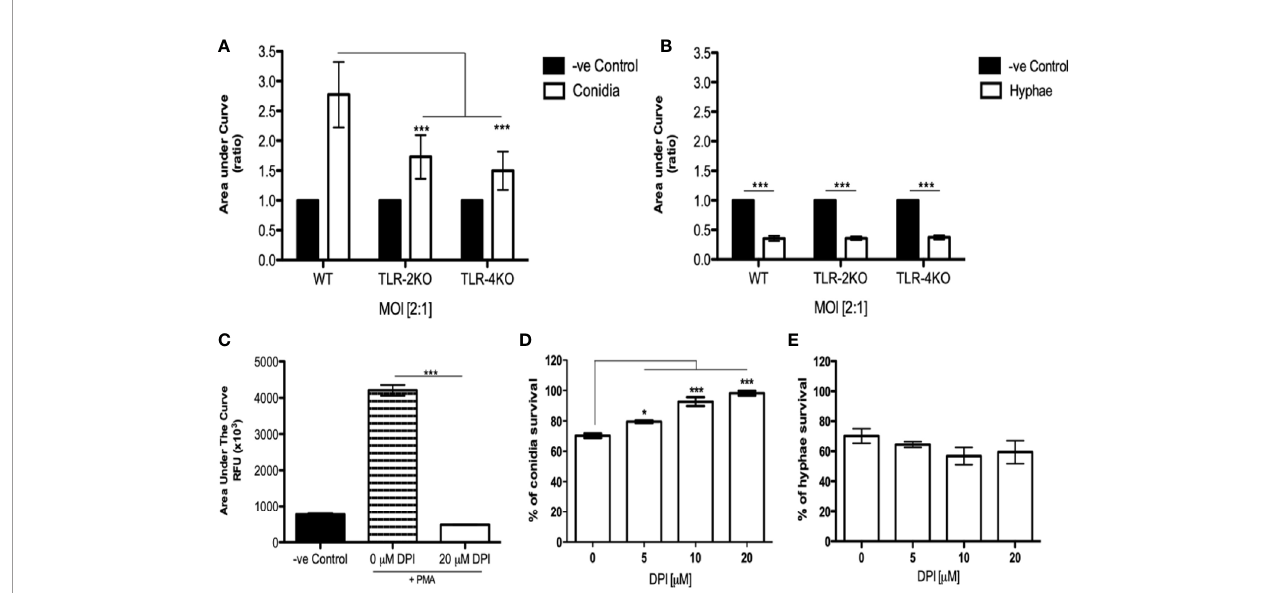
FIGURE 3 | Neutrophil ROS production by F. pedrosoi conidia is a mechanism relying on TLR-2 and TLR-4 and essential to conidial killing. WT, TLR-2KO, and TLR-4KO neutrophils were previously puri fi ed using Ficoll density layer and then seeded into a 96-well plate in the presence of a luminol reagent and stimulated with F. pedrosoi conidia (A) or hyphae (B) . As unstimulated control, neutrophils were incubated in the absence of fungi to measure the ROS production during the steady state. The ROS production was measured every 2 min to approximately 60 min, and the area under the curve was calculated to measure the total ROS production after stimulation. The area under the curve ratio was calculated using the control of each group (WT, TLR-2KO, or TLR-4KO) and setting as 1. Data are expressed as mean ± SEM; n =5, two-way ANOVA with Bonferroni ’ s posttest. *** p <0.001. To verify whether hyphal/conidial killing was dependent on ROS production, we used a range of concentrations of DPI, a potent NADPH-oxidase inhibitor. First, we incubated WT neutrophils with DPI (or not) and stimulated them with PMA. ROS production was measured to con fi rm the inhibition activity of the drug (C) . Then, using a range of DPI concentrations (0 – 20 m M), we analyze the importance of ROS production in hyphal/conidial killing. After preincubation with DPI, the puri fi ed neutrophils were incubated with conidia (D) or hyphae (E) for 2 h After incubation, the cells were lysed with distilled water, and the supernatant was seeded onto Sabouraud agar at 37°C for 5 days. Data are expressed as mean ± SEM; n =4, one-way ANOVA with Bonferroni ’ s posttest. * p <0.05; *** p CXCL1 and CCL3 production in TLR-2KO and TLR-4KO animals affects neutrophil migration to the infection site.